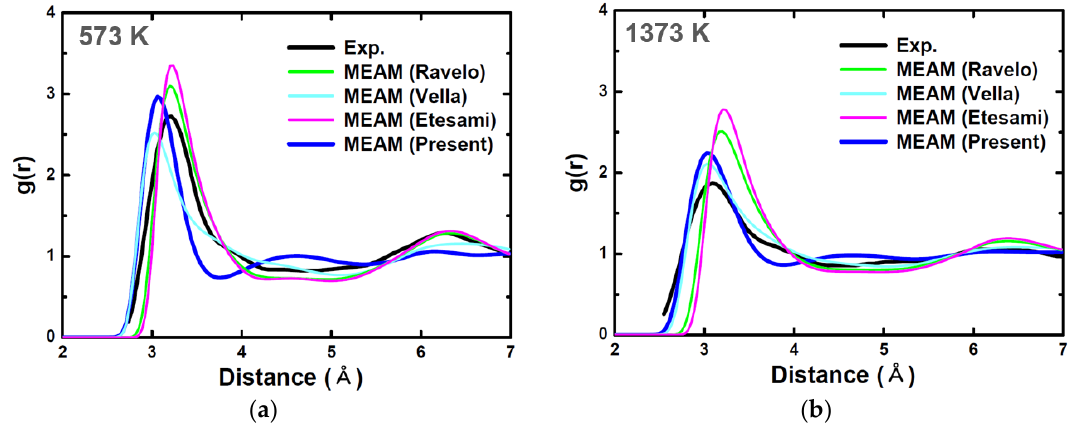
Figure 3. Calculated radial distribution function of liquid Sn at ( a ) 573 K and ( b ) 1373 K using the present 2NN MEAM potential, in comparison with experimental data (Ref. [7]) and the calculation results using previous MEAM potentials by Ravelo and Baskes [5], Vella et al. [12], and Etesami et al. [13].